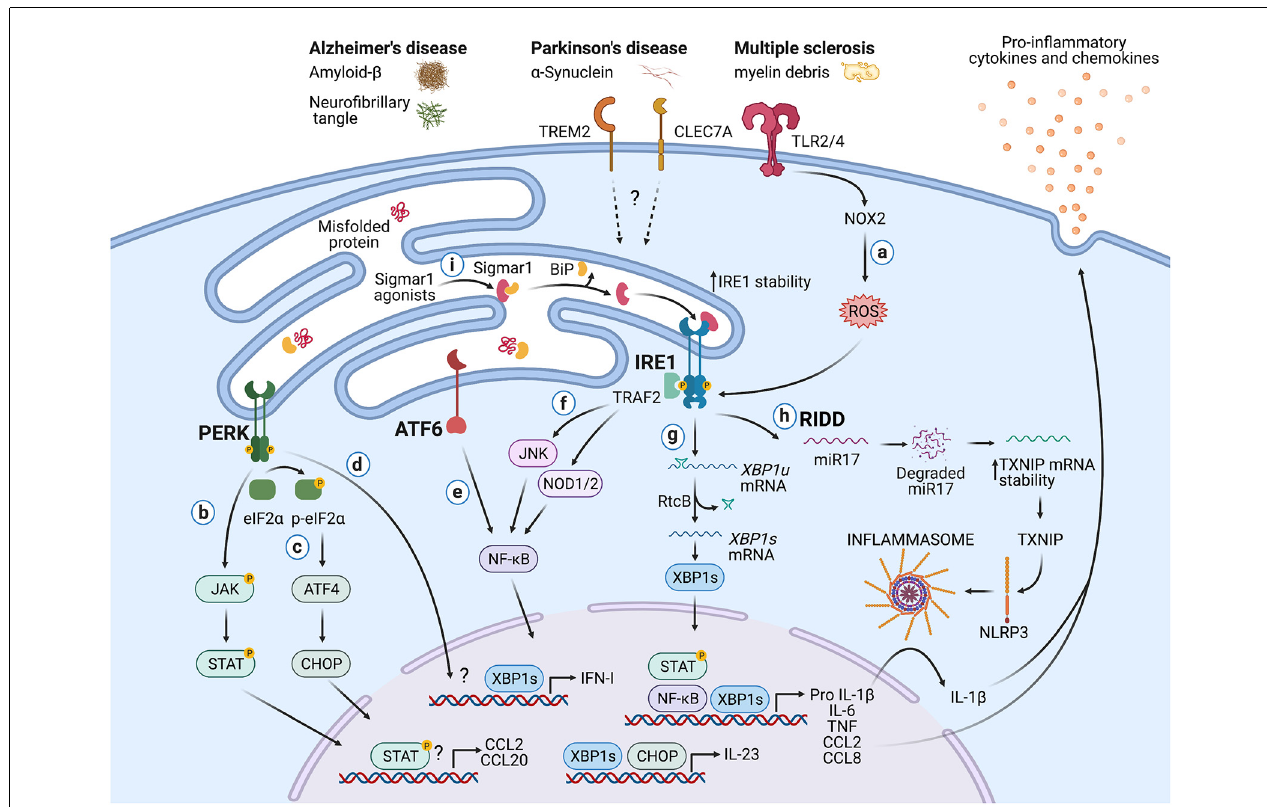
FIGURE 2 | Potential roles of the UPR in immune cells during neurodegeneration. Protein aggregates and myelin debris can promote inflammation via triggering of innate receptors and activation of the UPR, which in turn could increase inflammation in neurodegenerative diseases mainly by enhancing the production of proinflammatory cytokines and chemokines. (a) Detection of proteins aggregates (Amyloid- β , α -synuclein, neurofibrillary tangles) and myelin debris through TLR2 and TLR4 (and probably others pattern recognition receptors) present on immune cells can activate the IRE1/XBP1s axis through reactive oxygen species (ROS) production by NOX2. (b) PERK can modulate the production of the pro-inflammatory cytokines IL-6, TNF, IL-1 β , and the chemokines CCL2 and CCL20 through activation of JAK1-STAT3 and JAK2-STAT1 signaling pathways. (c) PERK also can control the synthesis of IL-23 via CHOP. (d) Additionally, PERK could control